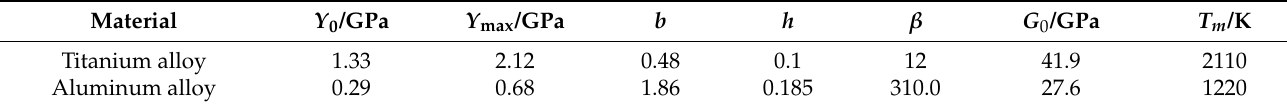
Table 2. Parameters of Steinberg Guinan model for titanium and